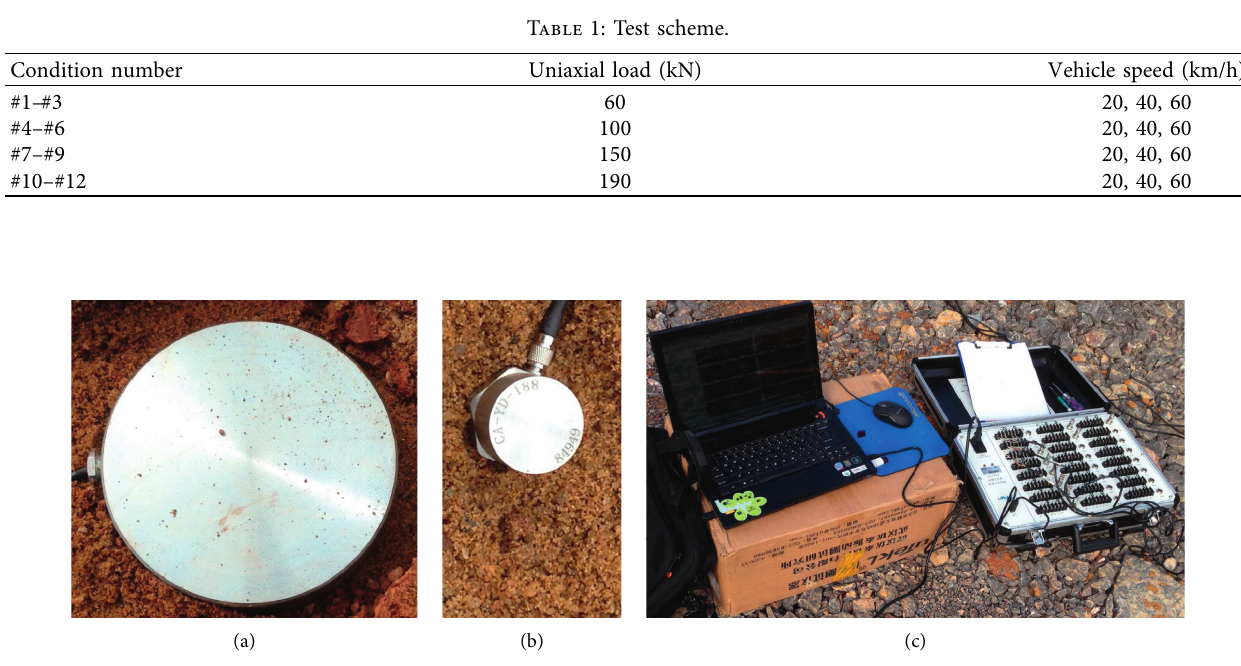
Figure 1: Sensor and data acquisition system: (a) strain Earth pressure cell, (b) accelerometer, (c) data acquisition system.